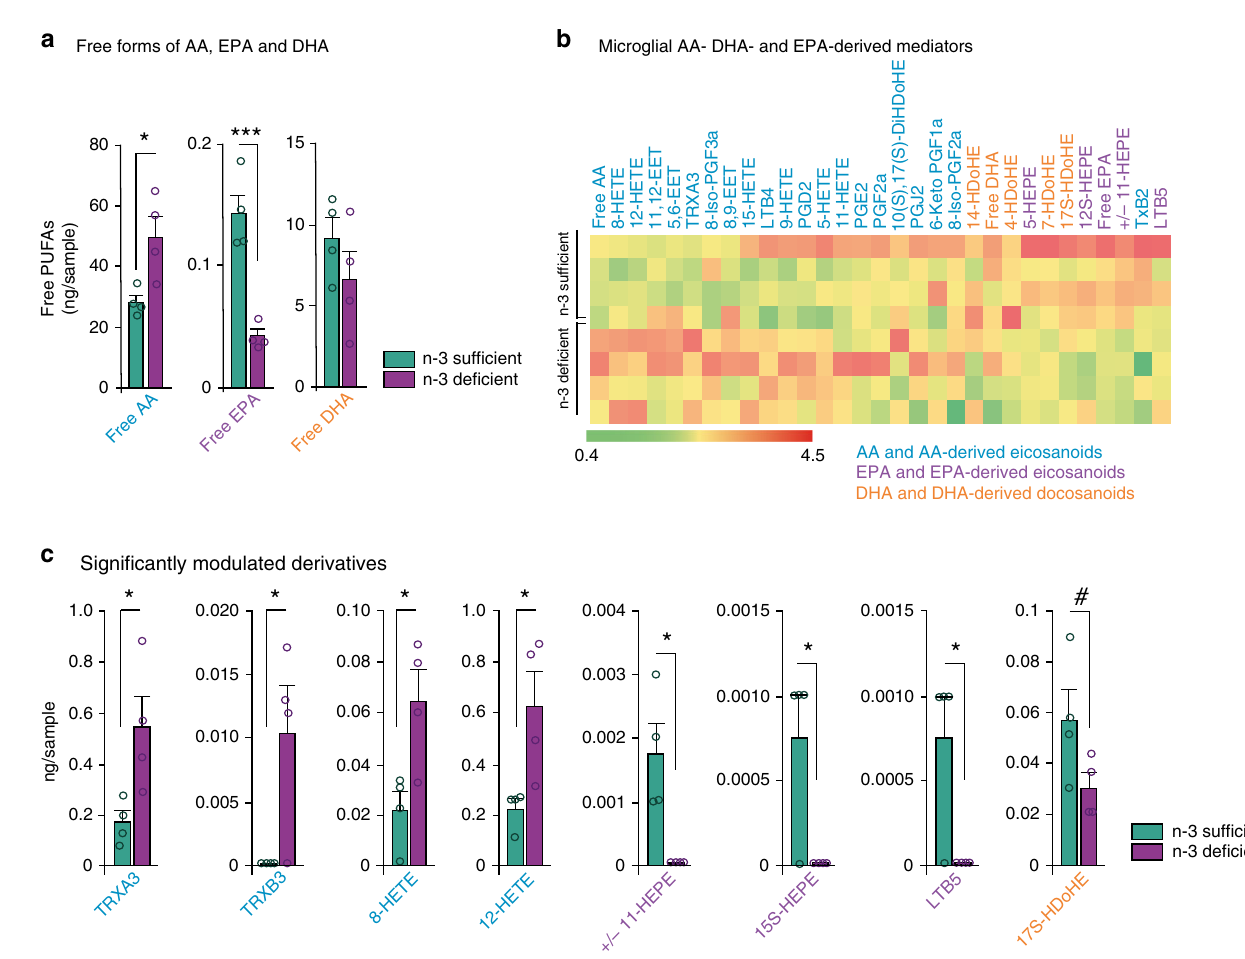
Fig. 5 Maternal n-3 PUFA de fi ciency alters fatty acid pro fi le in microglia. a Quanti fi cation of free (unesteri fi ed) forms of AA, EPA, and DHA levels in microglia. Means ± SEM; n = 4 mice per group. Two-tailed unpaired Student ’ s t -test; t = 3, * p = 0.024, free AA; t = 6.12, *** p = 0.0009, free EPA; t = 1.149, p = 0.2942, free DHA. b Heat map of all AA-, EPA-, and DHA-derived intracellular mediators expressed by microglia. c AA- EPA- and DHA-derived mediators that are signi fi cantly modulated by early-life n-3 PUFA de fi cient diet. Means ± SEM; n = 4 mice per group. Two-tailed unpaired Student ’ s t -test; t = 2.693, * p = 0.0359, TRXA3; t = 2.867, * p = 0.0286, TRXB3; t = 3.028, * p = 0.0231, 8-HETE; t = 2.886, * p = 0.0278, 12-HETE; t = 3.656, * p = 0.0106, + / − 11-HEPE; t = 3, * p = 0.024, 15S-HEPE; t = 3, * p = 0.024, LTB5; t = 1.975, p = 0.0957, 17S-HDoHE. Source data are provided as a Source data fi